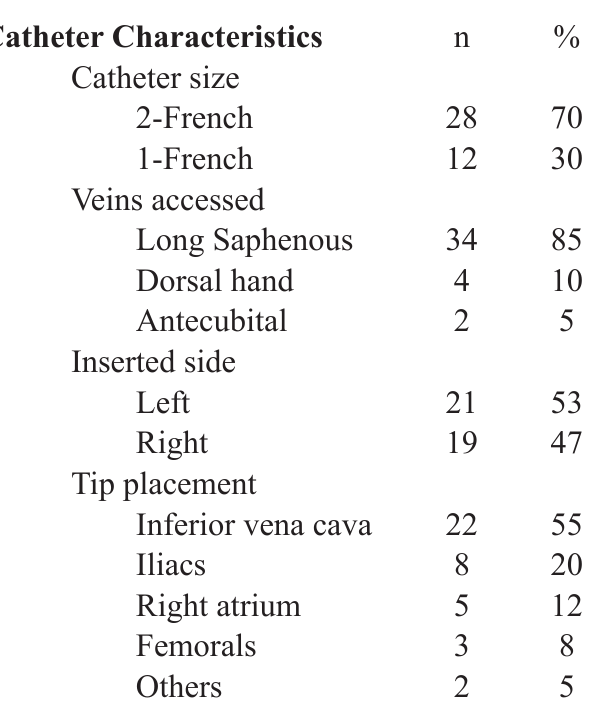
FIGuRE 3 - The insertion of the 1-F PICC by using pre-cut-semi-split introducer that prepared with our technique and transparent adhesive dressing with removed introducer ( asterisk ). 491x309mm (150 x 150 DPI).